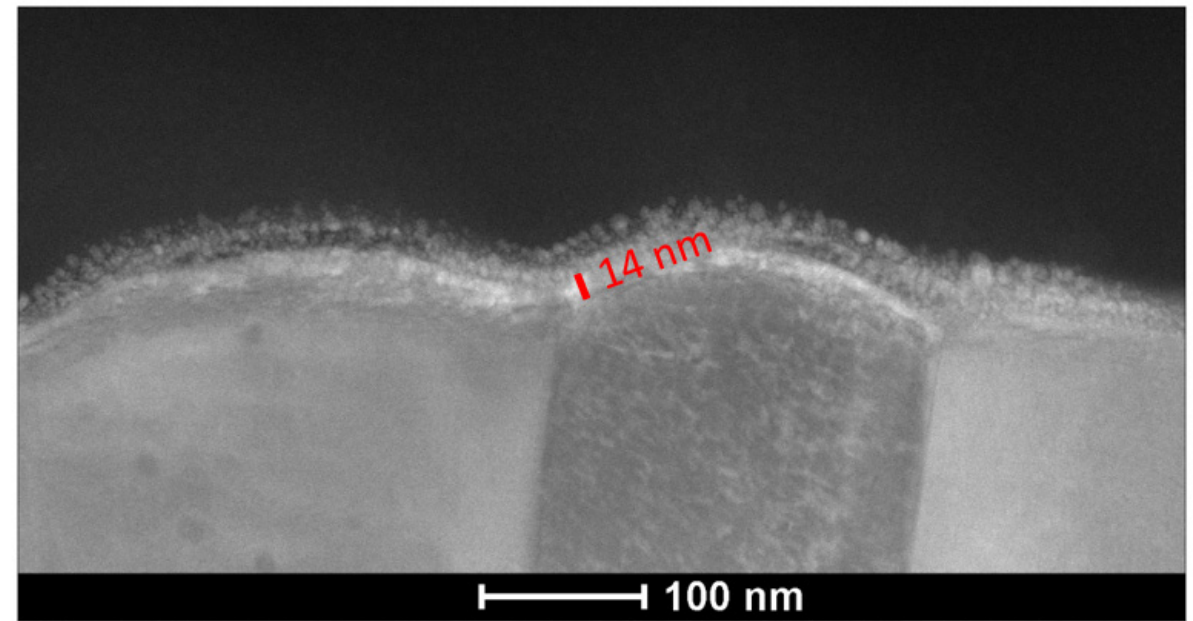
Figure 2. TEM image of the LNO coated NMC-60 showing a dense coating layer with a thickness of 14 nm has been formed, which is two-thirds of the theoretical thickness of 21 nm for a 1 wt.% of LNO coating on NMC-60 (work performed at the Center for Nanoscale Materials at Argonne National Laboratory).